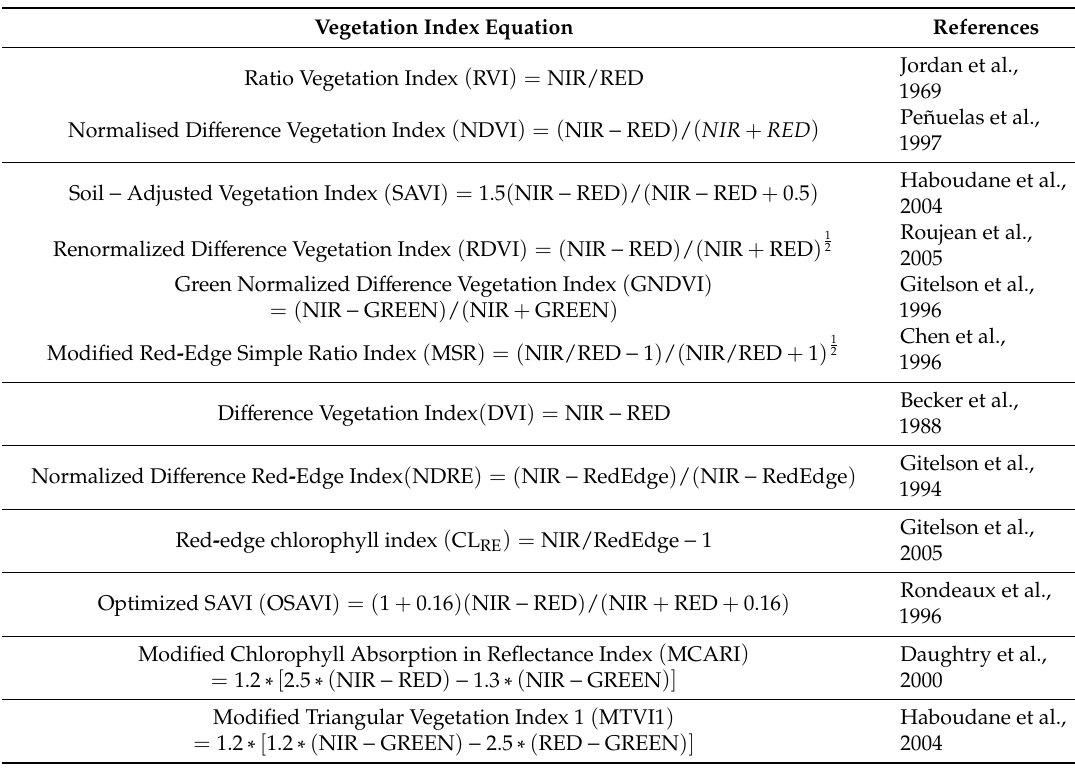
Table 2. Definition of the selected vegetation indices